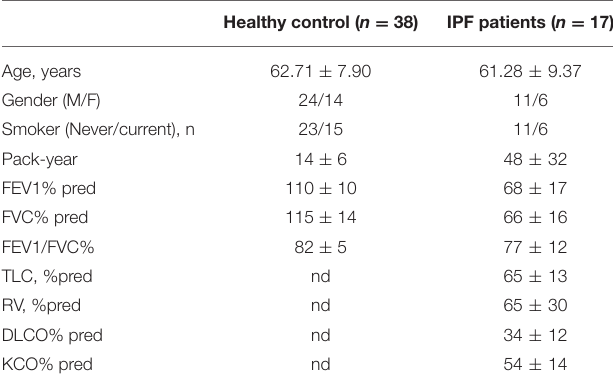
TABLE 1 | Patient